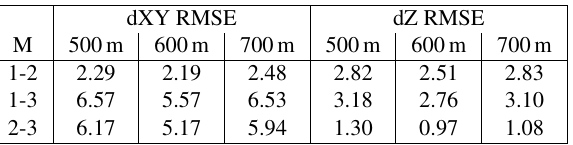
Table 2. Discrepancies between the coordinates obtained from the different correction methods M i (M 1 - M 2 , M 1 - M 3 , M 2 - M 3 ) in percent of the water depth for different flying heights (500m, 600m, 700m).